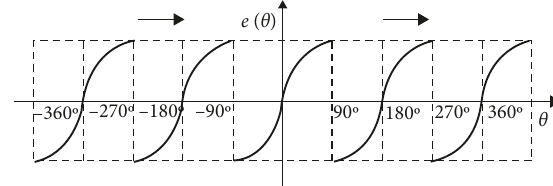
Figure 5: Change rule chart of e ( θ ) when ball screw is moving in a positive